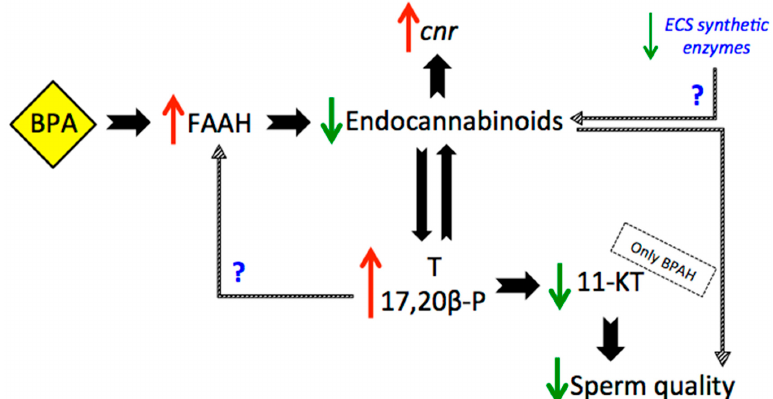
Figure 7. Summarized results. Abbreviations: BPAH (BPA HIGH group), FAAH (Fatty acid amide hydrolase), cnr (endocannabinoid receptors), T (testosterone), 11-KT (11-Ketotestosterone). Red arrows: increase, green arrows: decrease.